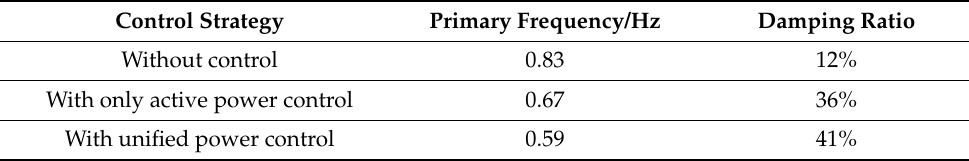
Table 5. The Damping ratio changing situations with different